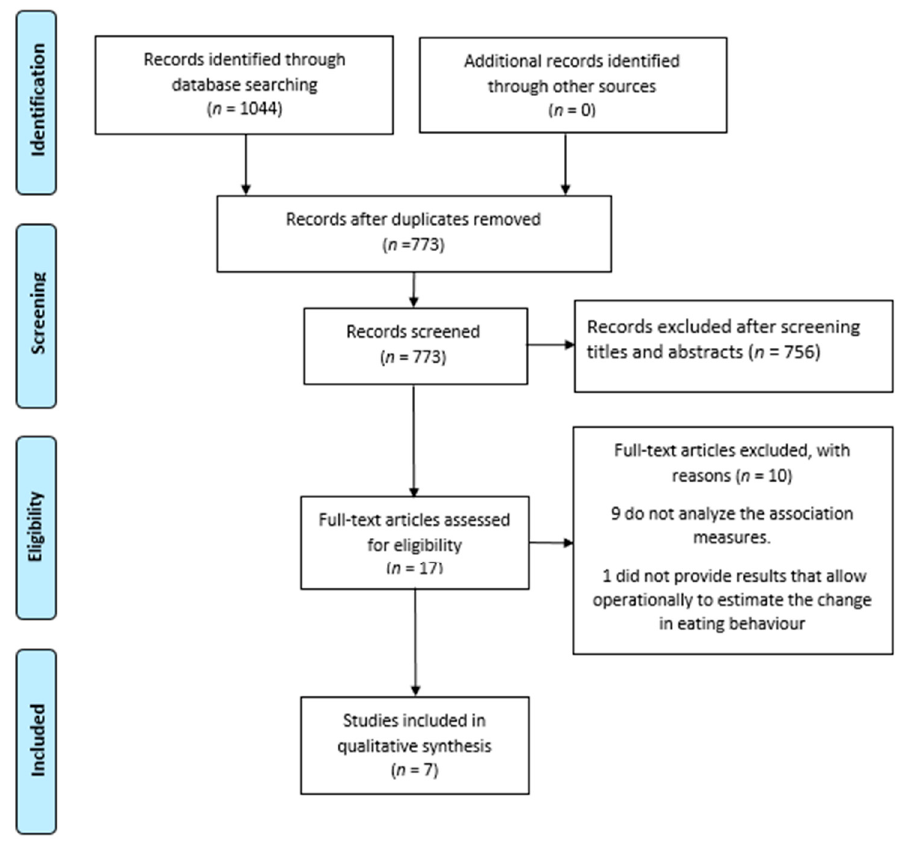
Figure 1. Article selection included in the analysis.